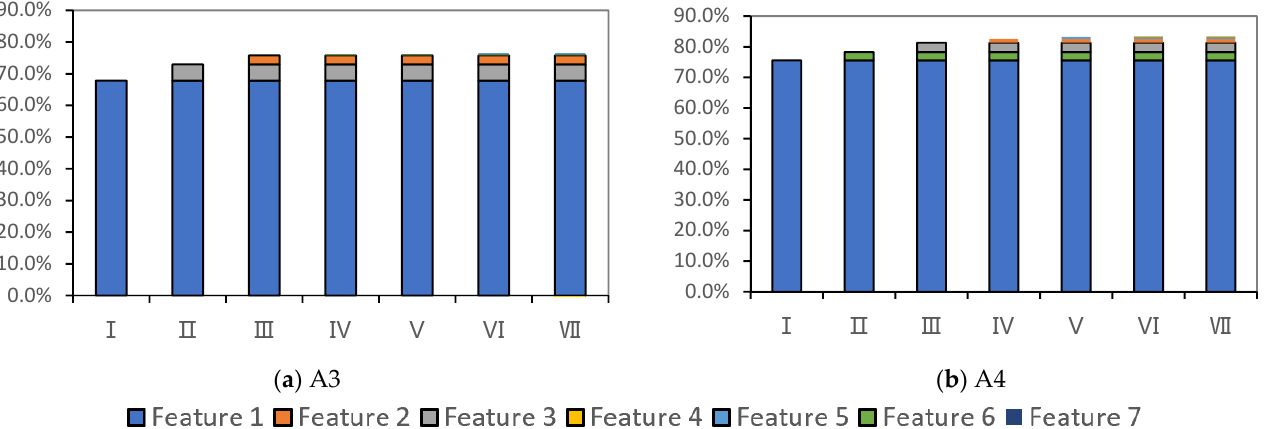
Figure 5. Overall classification accuracy after adding features according to PCA ranking for test area A3, A4.